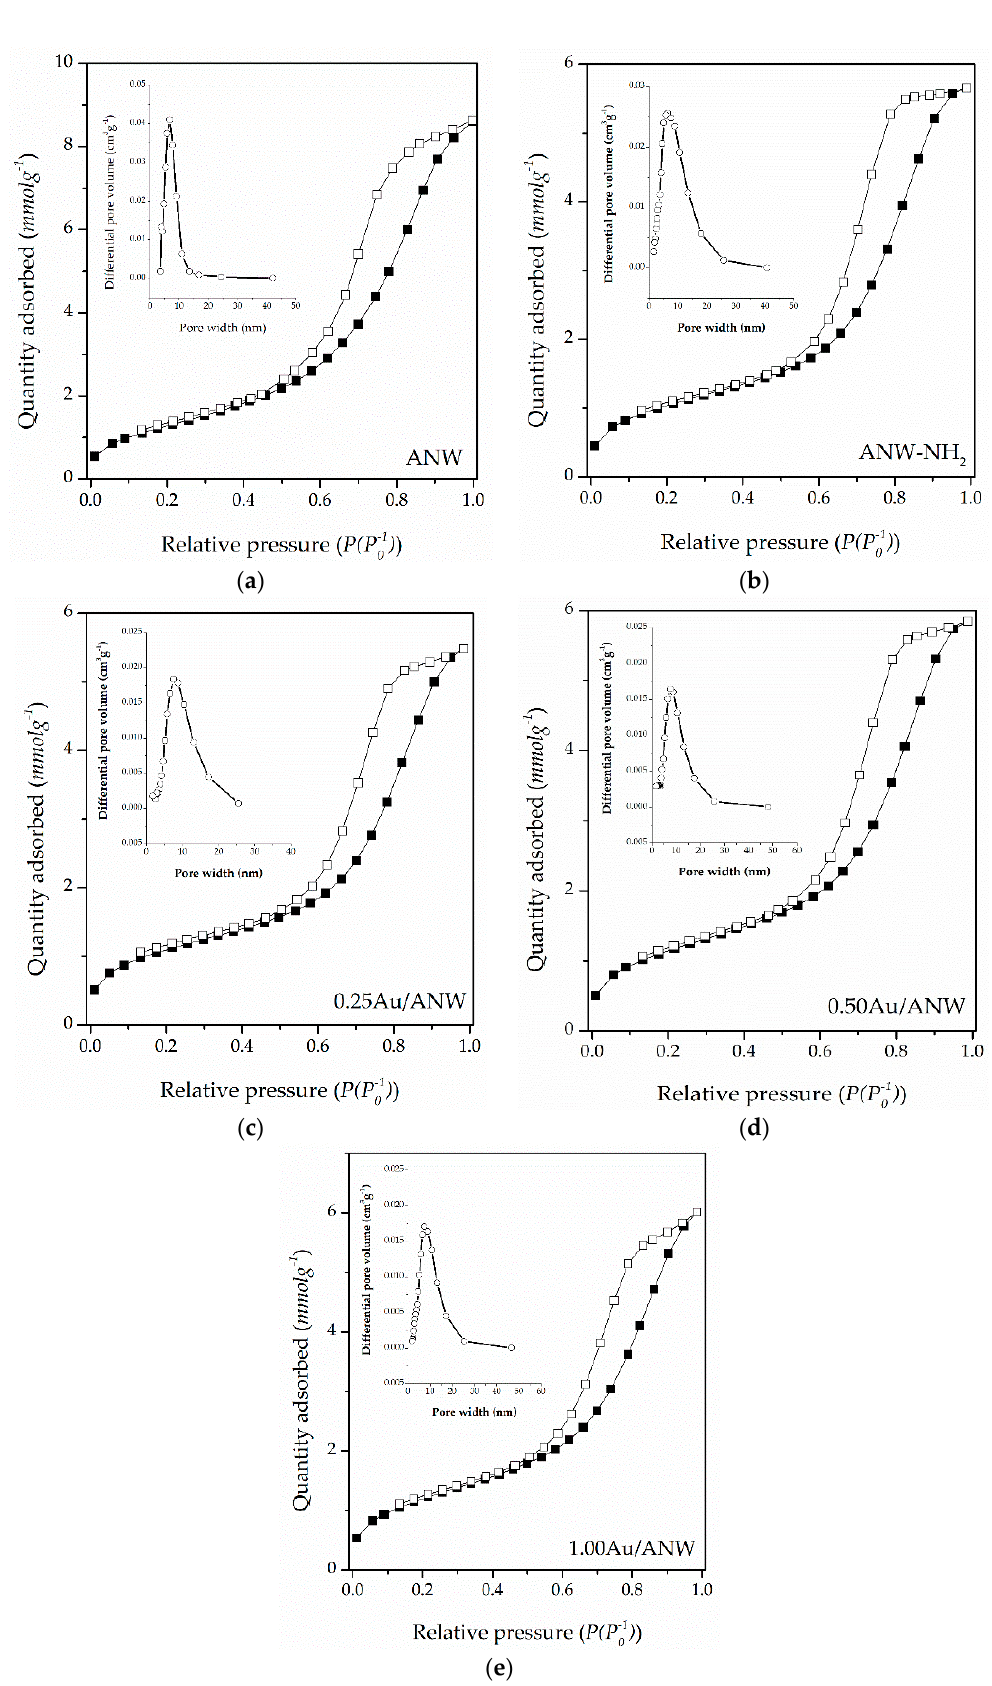
Figure 2. N 2 adsorption–desorption isotherms and pore-size distribution curves of the prepared materials. ( a ) ANW; ( b ) ANW-NH 2 ; ( c ) 0.25Au/ANW; ( d ) 0.50Au/ANW; ( e ) 1.00Au/ANW. Close square corresponds to adsorption branch and open square corresponds to the desorption branch.